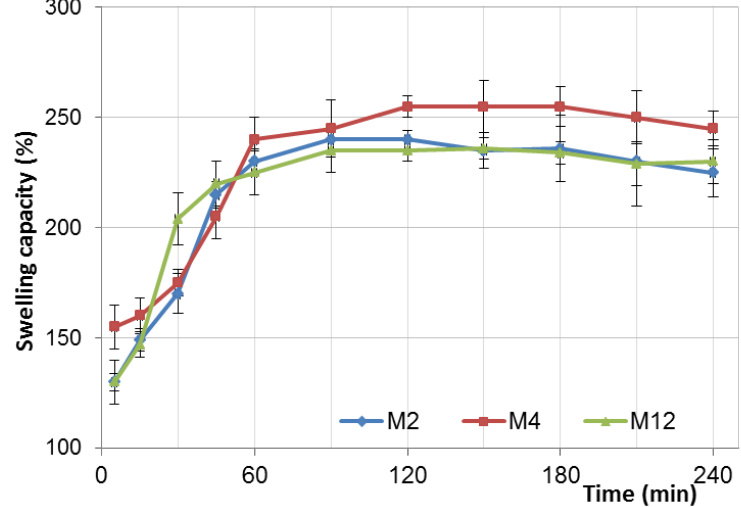
Figure 8. Swelling index study of the selected microparticle formulations with a ratio gCS:CF of 1:1 (M12), 2:1 (M2), 3:1 (M4) (mean ± SD; n =